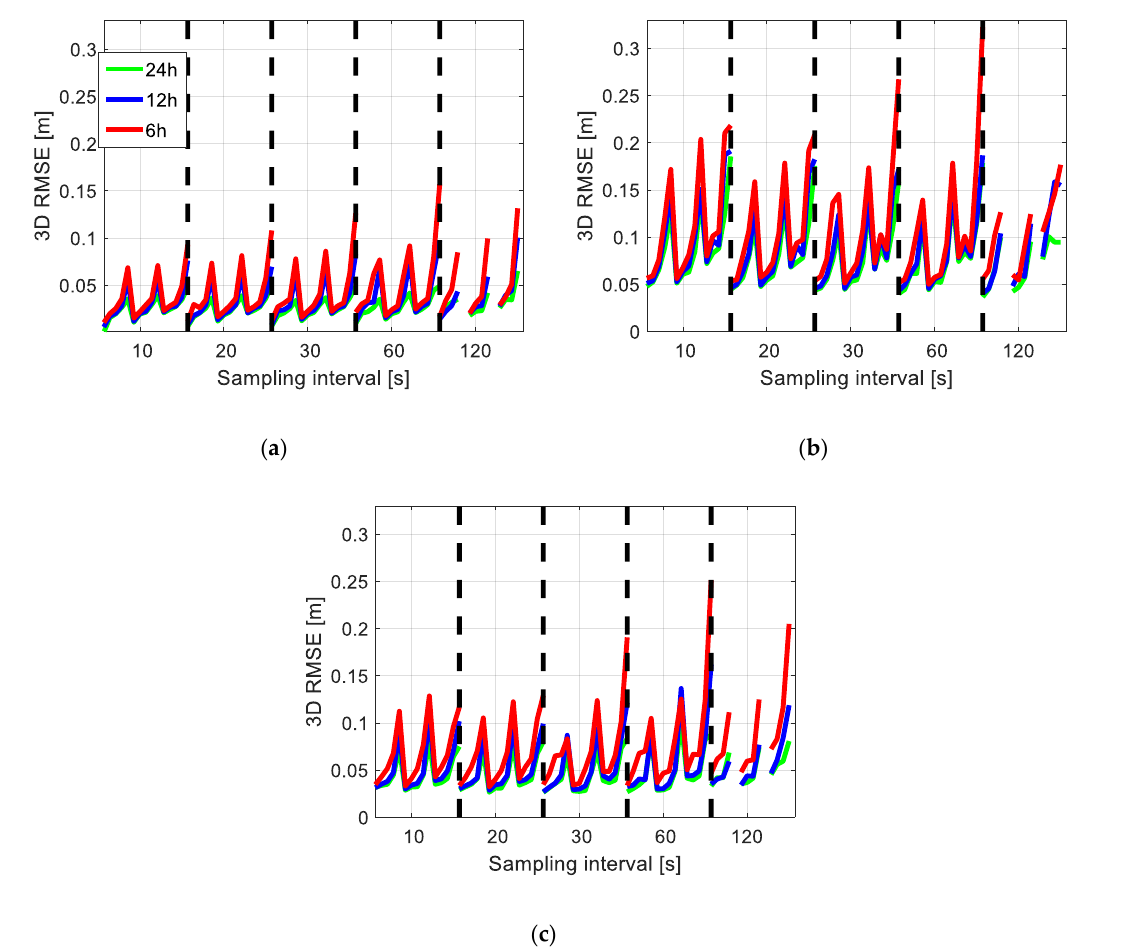
Figure 14. 3D RMSE of the reduced-dynamic orbits when processing with the arc lengths of 24 h, 12 h, and 6 h applying ( a ) the IGS final products, ( b ) the IGS rapid (IGR) products, and ( c ) the IGS real-time (IGC) products. Between each pair of the dashed lines, the cases are sorted from the highest duty-cycle of 100% to the lowest duty-cycle of 20%, first for the mean satellite number of 9, and then similarly for the mean satellite numbers of 7 and 6, respectively.